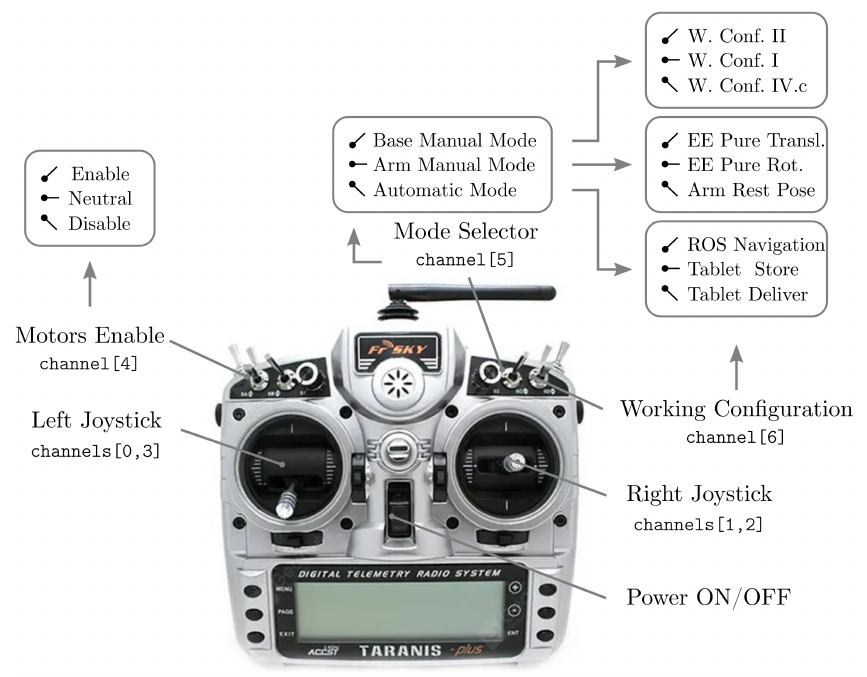
Figure 3. Digital telemetry radio system